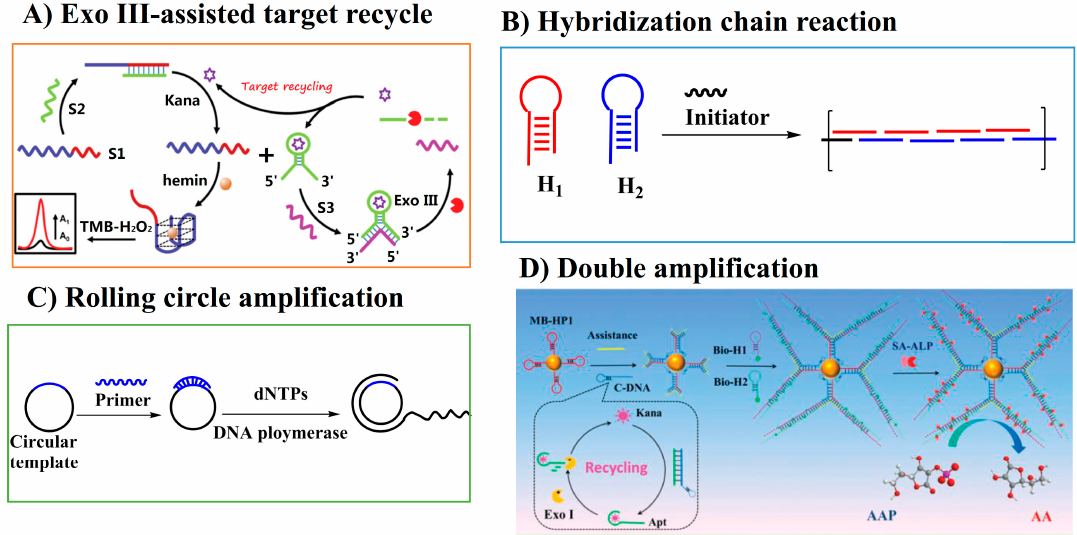
Figure 6. Schematic illustration of amplification strategies to improve the detection sensitivity of AGs (reprinted with permission from [20] Copyright (2019) Royal Society of Chemistry and [86] Copyright (2018) Royal Society of Chemistry).